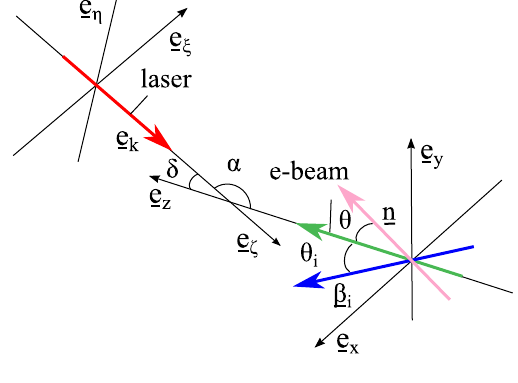
FIG. 2. Beam B — Simulation by A STRA . (1) Phase space. (a) Low energy and (b) high energy beamlets. (2) Total (c) and partial [(a) and (b)] electron current. (3) Energy distribution. FIG. 3. Geometry of the